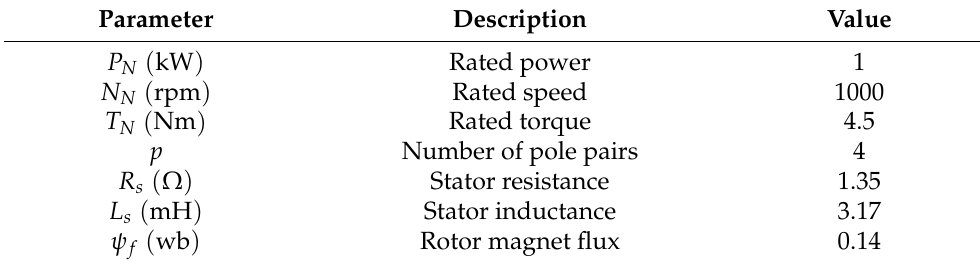
Table 1. Machine parameters.